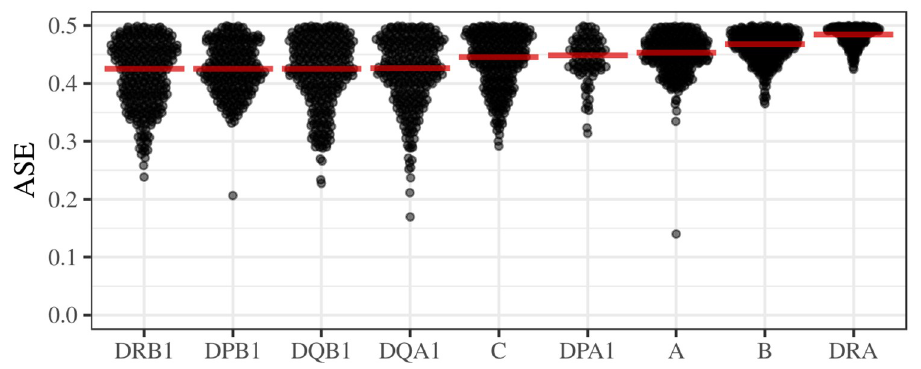
Fig 7. Allele-specific expression. ASE was measured as the proportion of the locus-level expression attributed to the less expressed HLA allele in heterozygous genotypes. Red horizontal bars indicate the median.